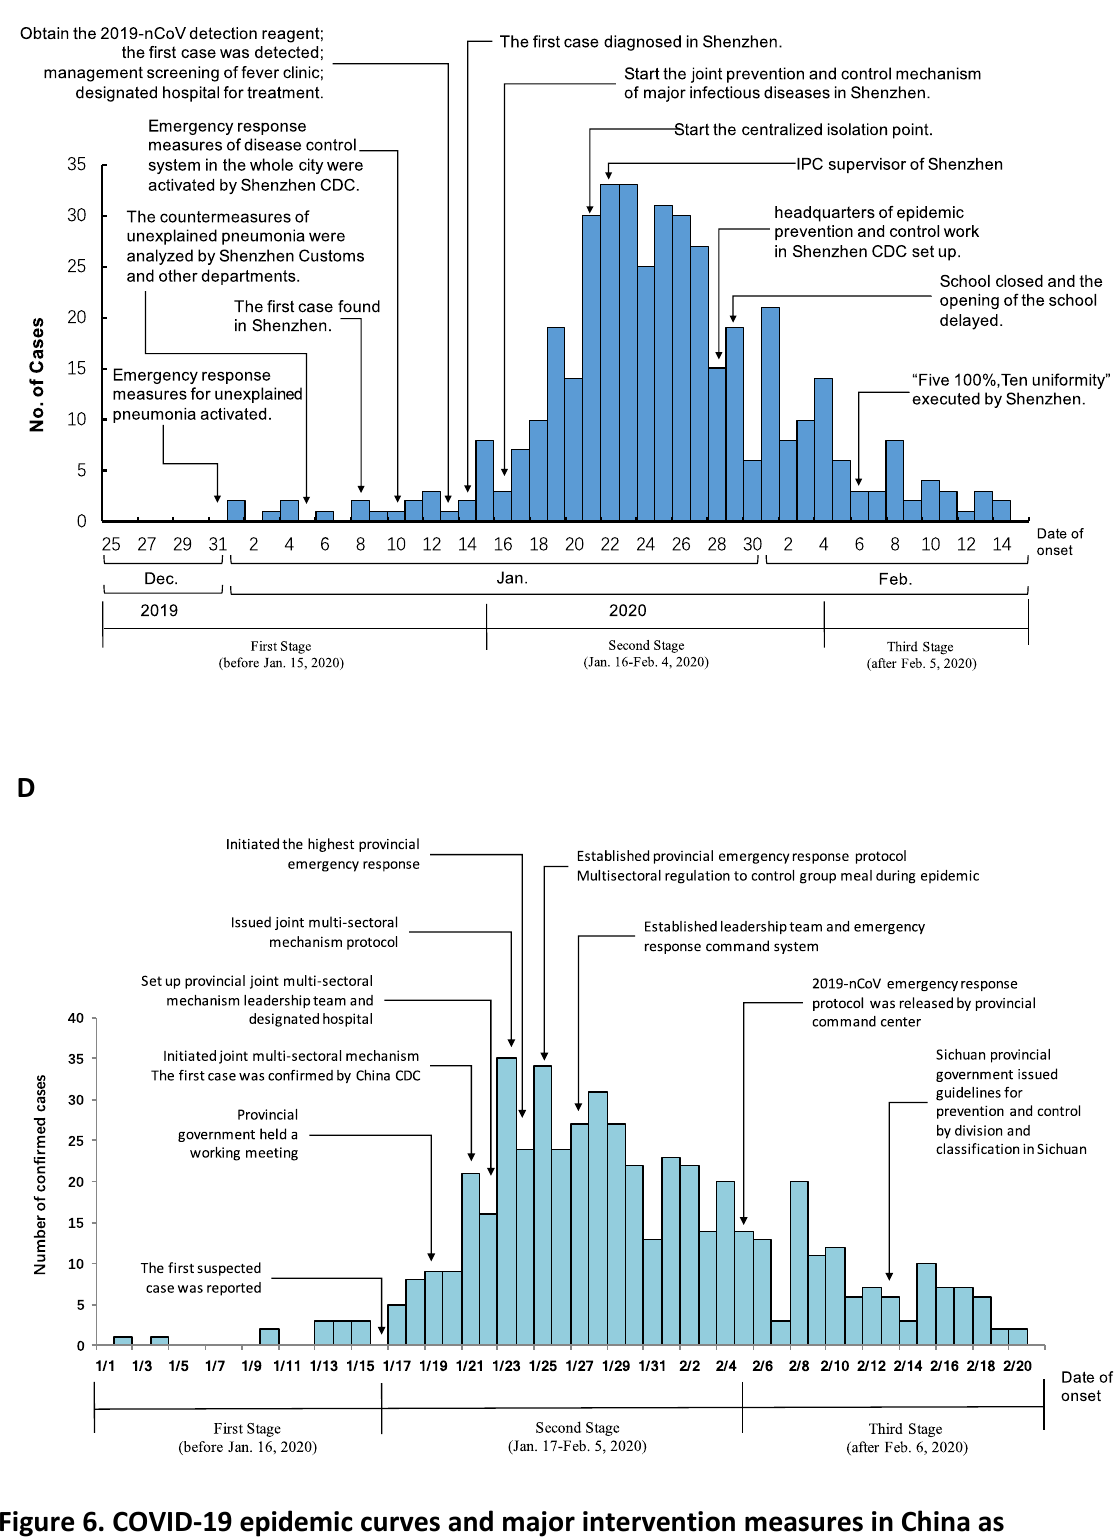
Figure 6. COVID-19 epidemic curves and major intervention measures in China as implemented at a) the national level b) in Guangdong province, c) in Shenzhen municipality and d) in Sichuan province